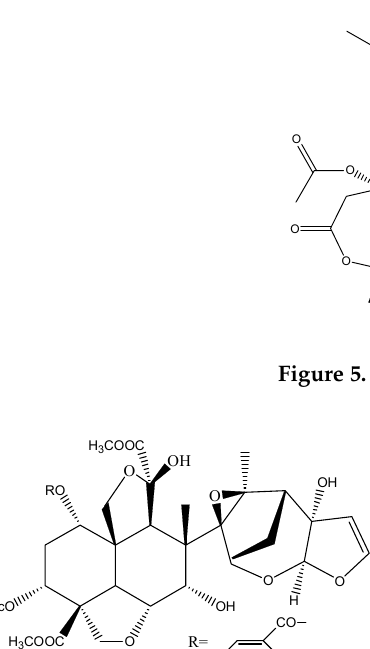
Figure 6. The structures of azadirachtin/meliacarpin-class chemicals.